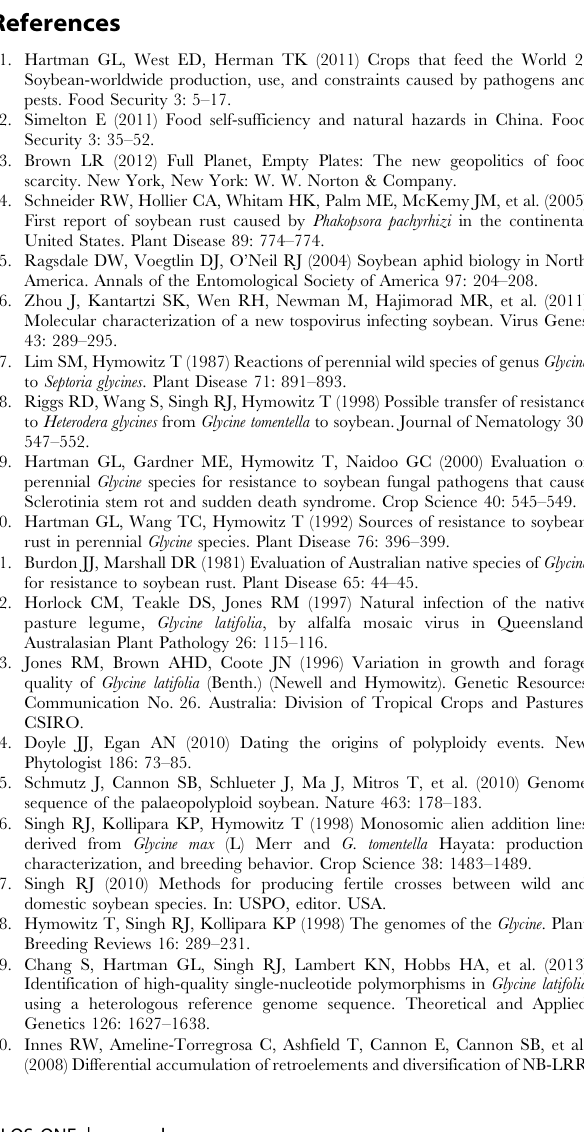
Table S1 GBS SNP Genotype data for the F 2 mapping population. Table S2 GBS SNP Genotype data for the F 5 mapping